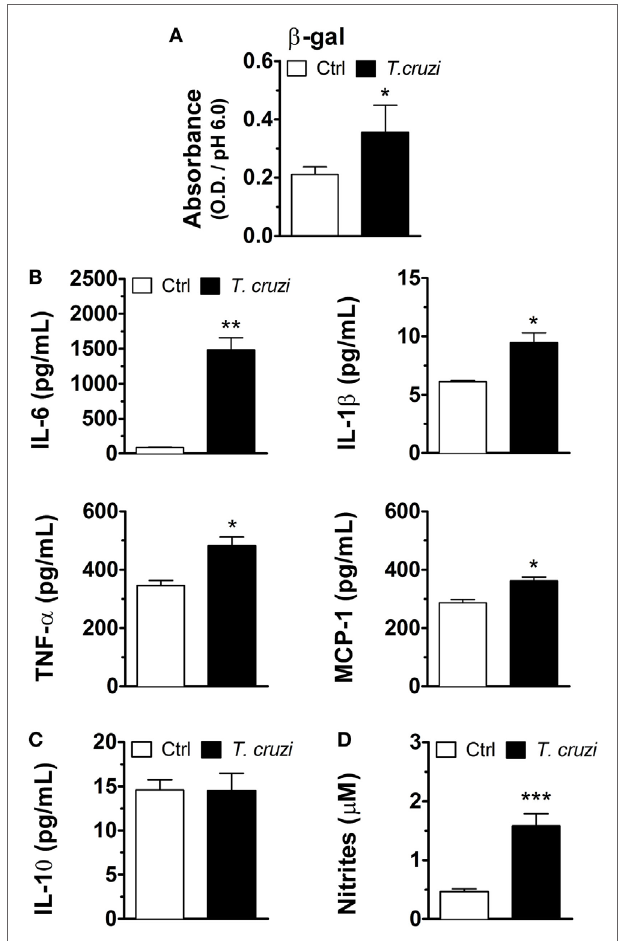
FigUre 3 | Trypanosoma cruzi -infected NIH-3T3 fibroblasts have characteristics of cellular senescence. NIH-3T3 fibroblasts were infected overnight with culture-derived T. cruzi trypomastigotes (MOI 5:1). (a) Evaluation of soluble SA- β -gal activity at pH 6.0 in cell lysates of T. cruzi -infected and non-infected fibroblasts 3 days post-infection. (B,c) Measurement of senescence-associated secretory phenotype (SASP) cytokines IL-6, TNF- α and IL-1 β and chemokine MCP-1, as well as SASP non-related IL-10, in the 3 days post-infection culture supernatants by ELISA. (D) Evaluation of nitric oxide release by T. cruzi -infected and non-infected fibroblasts in culture supernatants 3 days post-infection by Griess reaction. Data are presented as the mean ± SE of at least six biological replicates and analyzed by (a) non-parametric Mann–Whitney test, and (B–D) unpaired, two-tailed Student’s t -test, * p < 0.05; ** p < 0.01; *** p < 0.001; NS, statistically not significant, p > 0.05. Data are representative of at least three independent experiments with similar results. Abbreviations: MOI, multiplicity of infection; Ctrl, control; SA- β -gal, senescence-associated β